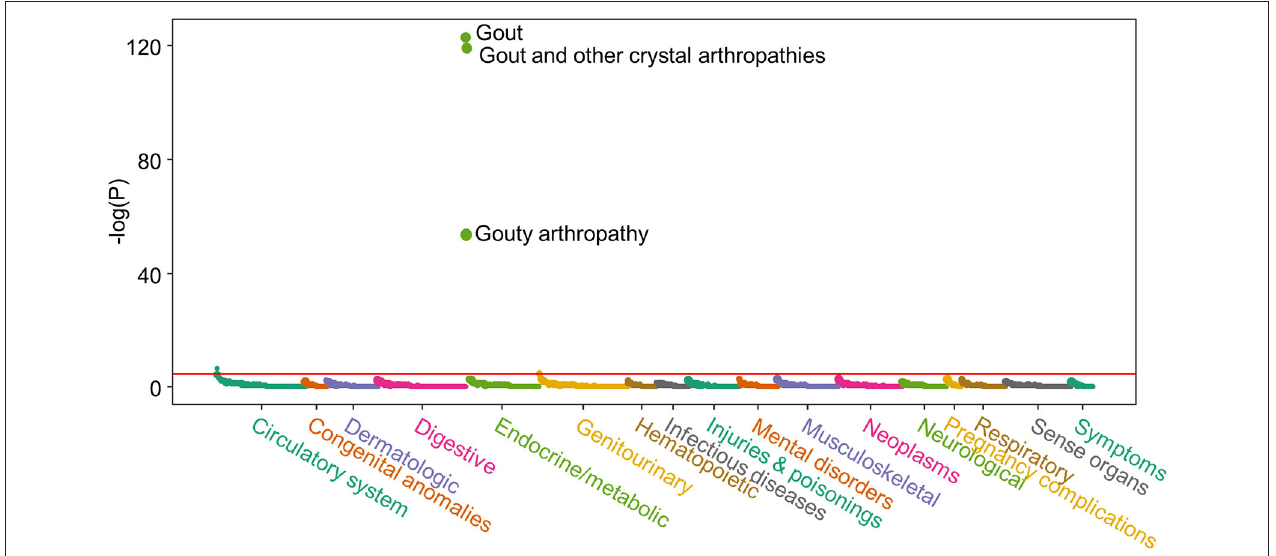
FIGURE 1 | Manhattan plot of the polygenic risk score (PRS)-phenome-wide association study (PheWAS) result. X-axis represents each phenotype; Y-axis represents the negative logarithm of the raw p -value of PRS term in the logistic regression model. Horizontal line indicates Bonferroni significant level ( p = 3.48e-5). Logistic regression model was adjusted for age, sex, BMI, and the first 10 genetic principal components to control the potential population structure. Supplementary Table 4 lists the results for phenotypes with p <